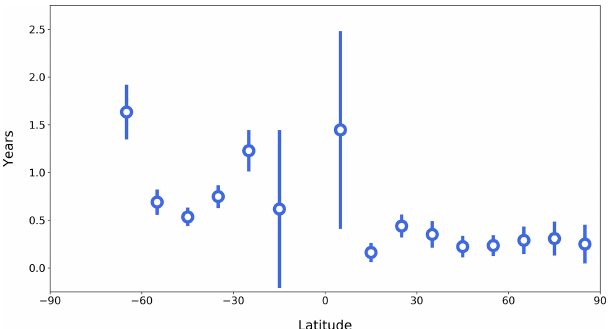
Figure 9. Delay in TCO return date (in years) per 200GgCl emis- sions for 10 ◦ latitude bins. Uncertainty bars represent the standard error of the estimate (calculation method provided in text). No val- ues are given for 90–80 ◦ S, 80–70 ◦ S, and 10 ◦ S–0 ◦ N as TCO in these latitude bands does not return to the 1960–1980 mean by the end of the model